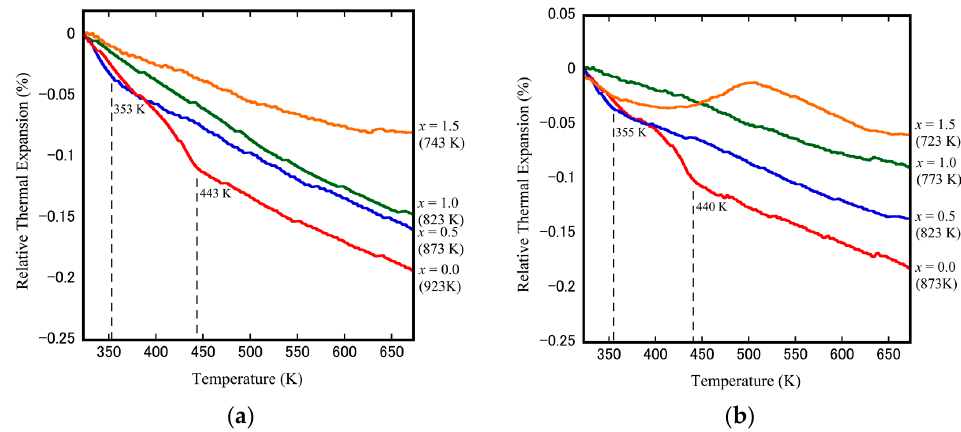
Figure 10. Thermomechanical analyzer results of cubic-ZrW 2 − x Mo x O 8 ceramics at different sintering temperature: ( a ) the higher sintering temperature ; ( b ) the lower sintering temperature.